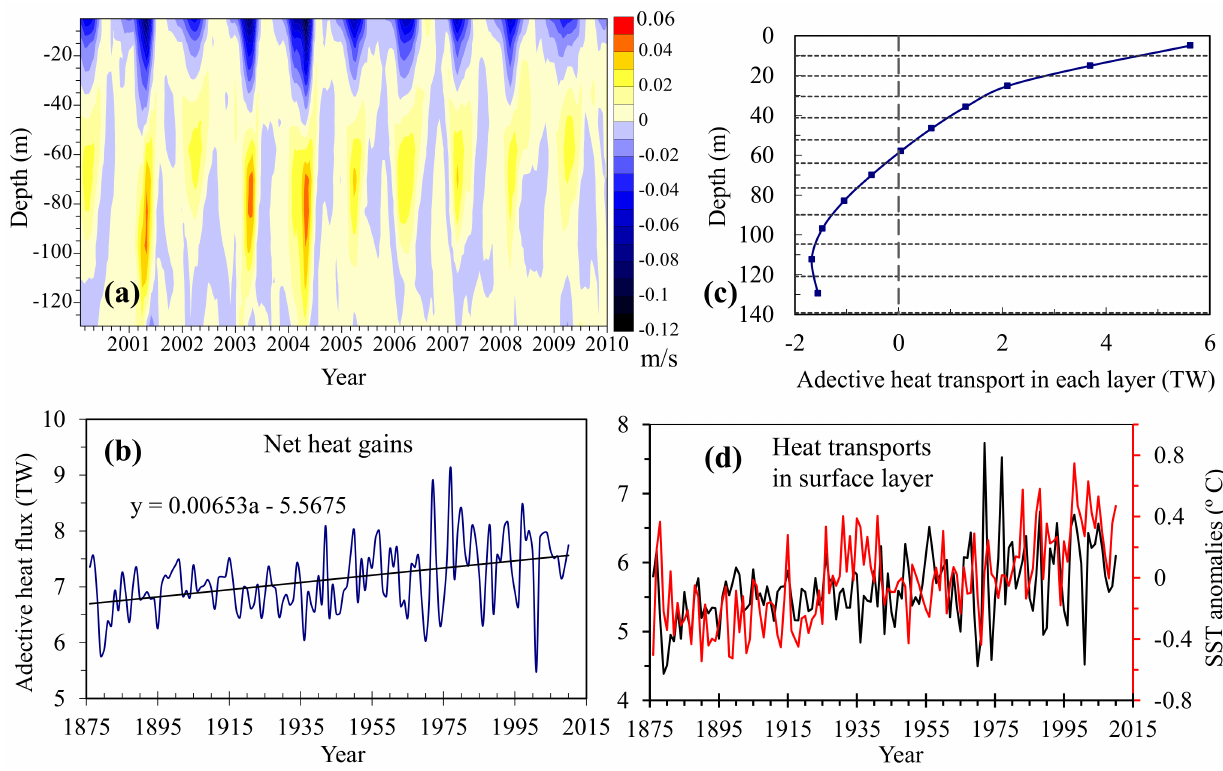
Figure 6. Advective transport between Red Sea and Gulf of Aden. ( a ) Monthly average zonal velocities at Bab-el-Mandab Strait for 2001–2010, with negative values corresponding to the